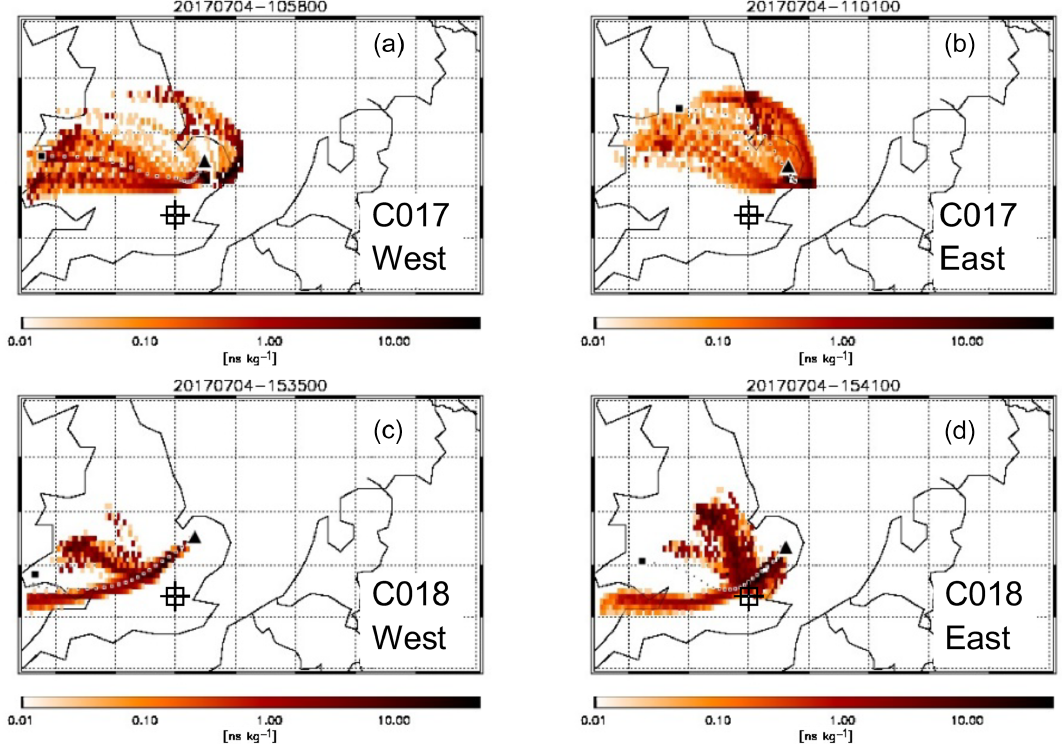
Figure 11. FLEXPART back-trajectories for air masses arriving at the location of FAAM BAe-146 as it intercepted the west (a, c) and east (b, d) plumes during the lowest of the reciprocal runs for flights C017 (a, b) and C018 (c, d) . Each coloured pixel indicates the relative contribution of an inert tracer in that air to the total tracer concentration sampled on board. The large black square shows the point of release of the air 24h prior to interception. The dotted line of black and white squares shows the hourly weighted average trajectory of the air mass based on the relative contributions shown. The square target indicates the approximate position of central